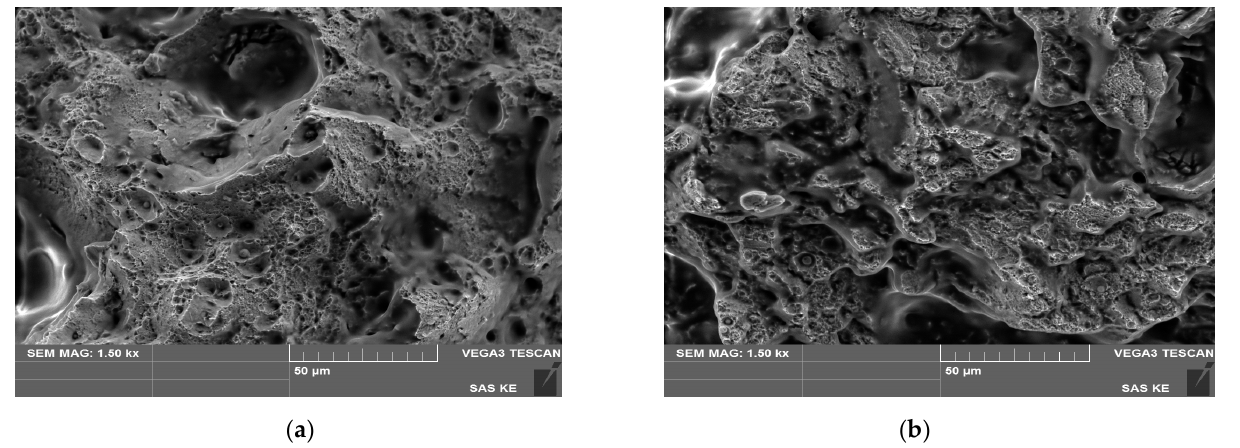
Figure 6. Surface of fracture samples: ( a ) Set 1, ( b ) Set 2 (×1500). Scale bar: 50 µm. Table 6 presents the measured results of the chemical composition of the material Ti6Al4V of both series of samples, which were examined by EDS analysis on the evaluated fracture surfaces. Table 6. Measured values of EDS analysis of the chemical composition of the material Ti6Al4V.